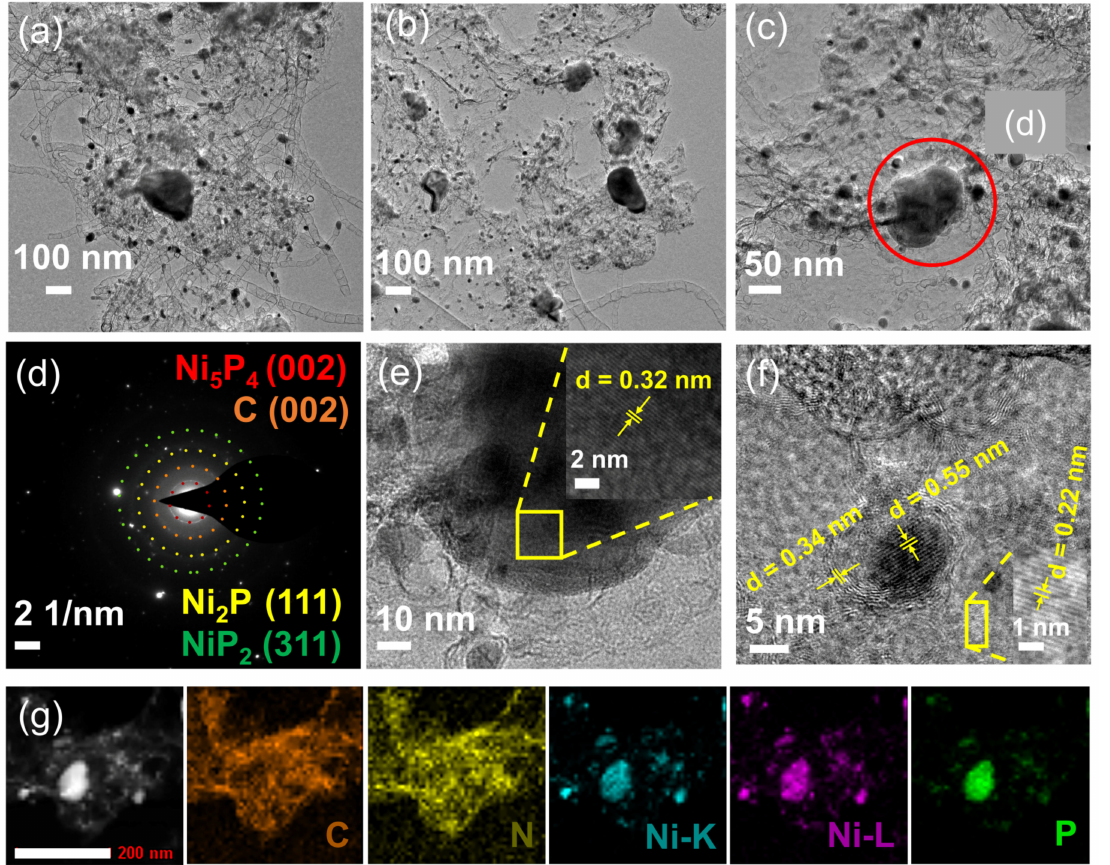
Figure 3. ( a – c ) TEM, ( d ) SAED pattern, ( e , f ) HRTEM, and ( g ) the corresponding elemental (C, N, Ni, and P) mappings of Ni 5 P 4 -NiP 2 -Ni 2